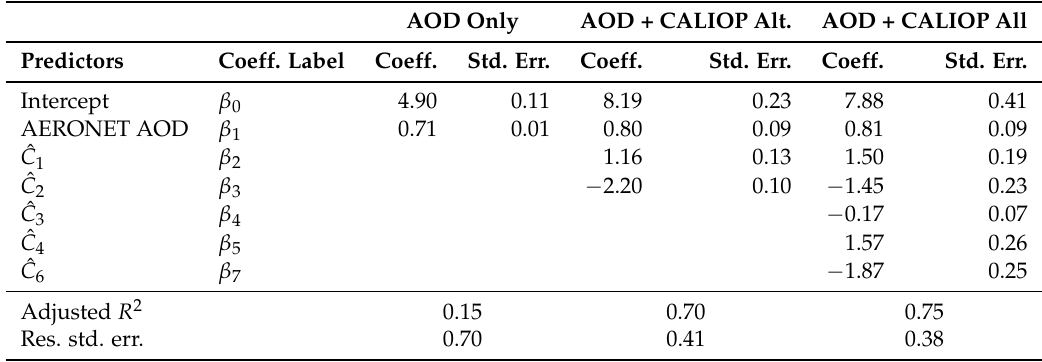
Table 1. Summary table of the multilinear regression parameters on the monthly variables (number of data = 280).